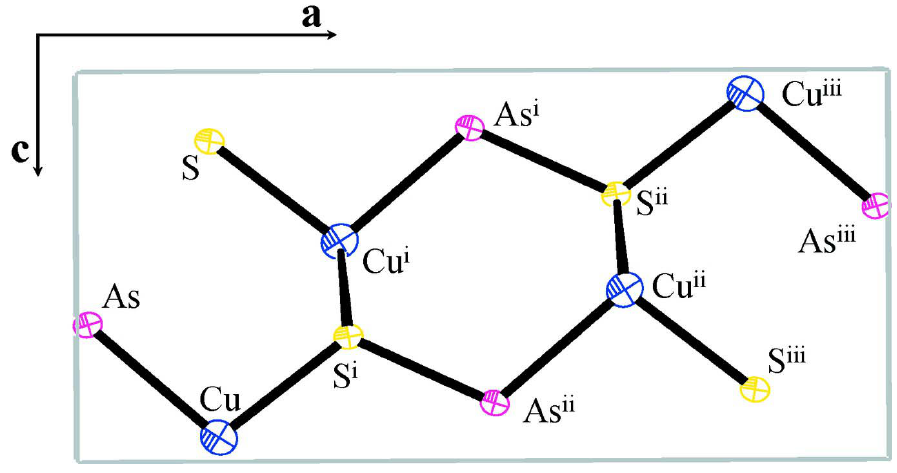
Figure 1 The crystal structure of lautite down [010]. Displacement parameters are drawn at the 70% probability level. The unit-cell is outlined. Symmetry codes are: (i) - x + 1/2; - y ; z + 1/2; (ii) x + 1/2; - y + 1/2; - z + 1/2; (iii) - x ; y + 1/2; - z .